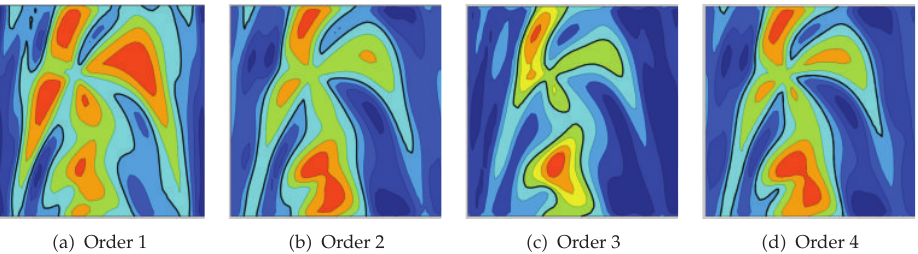
Figure 14: Error di ff erence of Helmholtz decomposition.